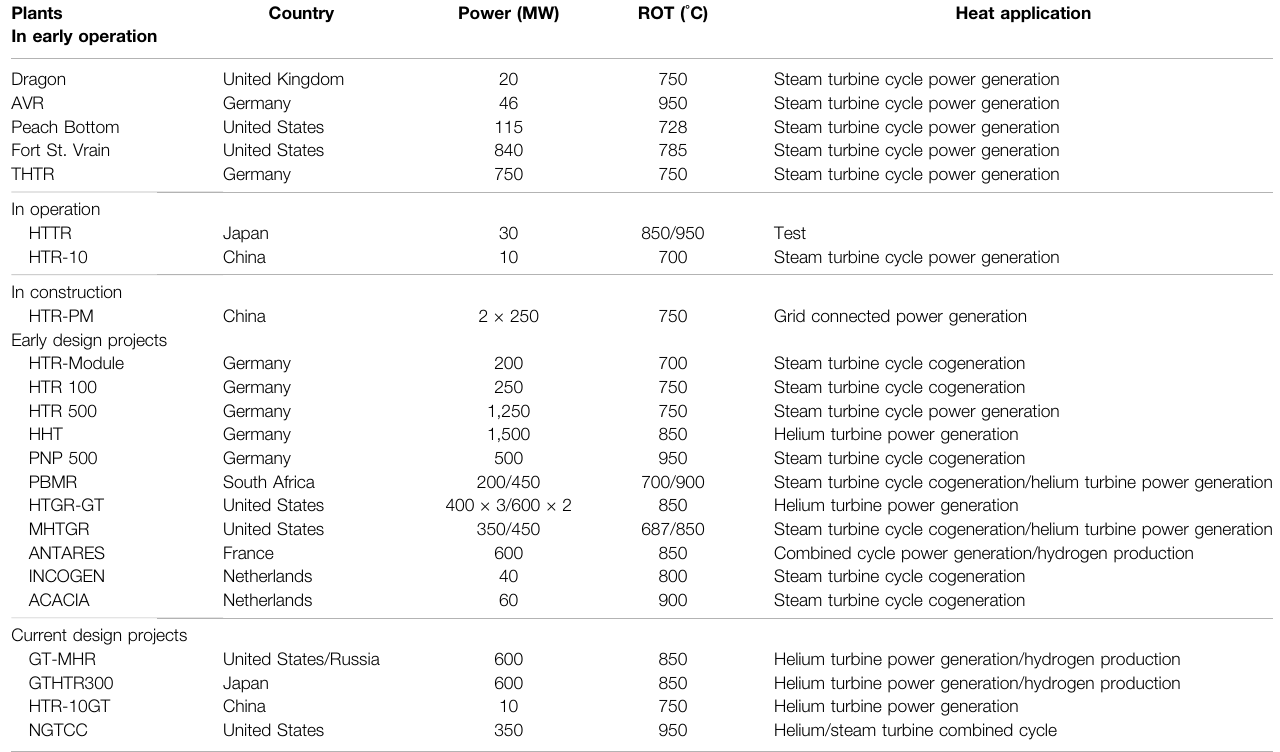
TABLE 1 | Representative HTGRs in different development stages, and their main technical parameters. Plants In early